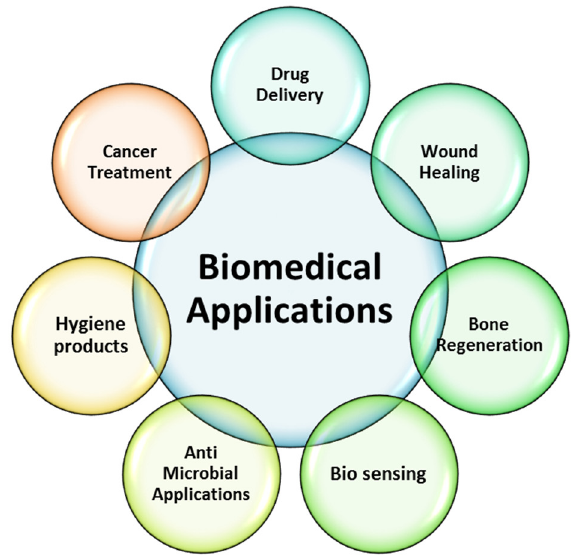
Figure 4. Biomedical applications of hydrogels.